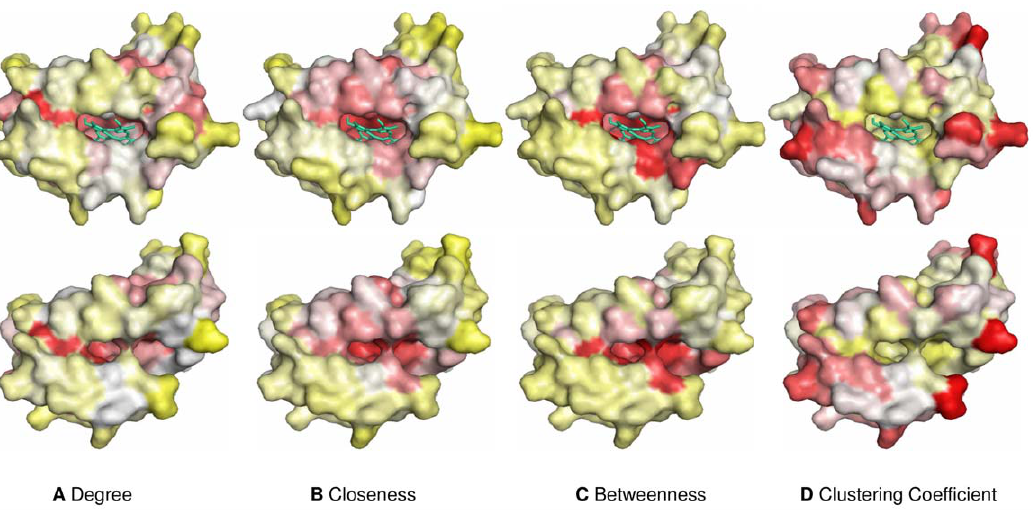
Figure 5. Visualization of the surface of holo-apo protein pair (2ZDO:A-1XBW:D). (a) Degree; (b) Closeness; (c) Betweenness; (d) Clustering Coefficient. The color of the surface was changed according to the z-scores of each network-based feature (red/white/yellow=high/medium/low). The heme molecule was shown as a cyan stick. The holo structures (2ZDO:A) were presented in the upper row, and the apo structures (1XBW:D) were presented in the lower row. This figure was produced by PyMOL (www.pymol.org).